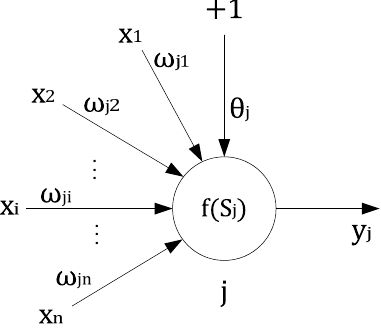
Figure 1. Mathematical model of a single neuron.